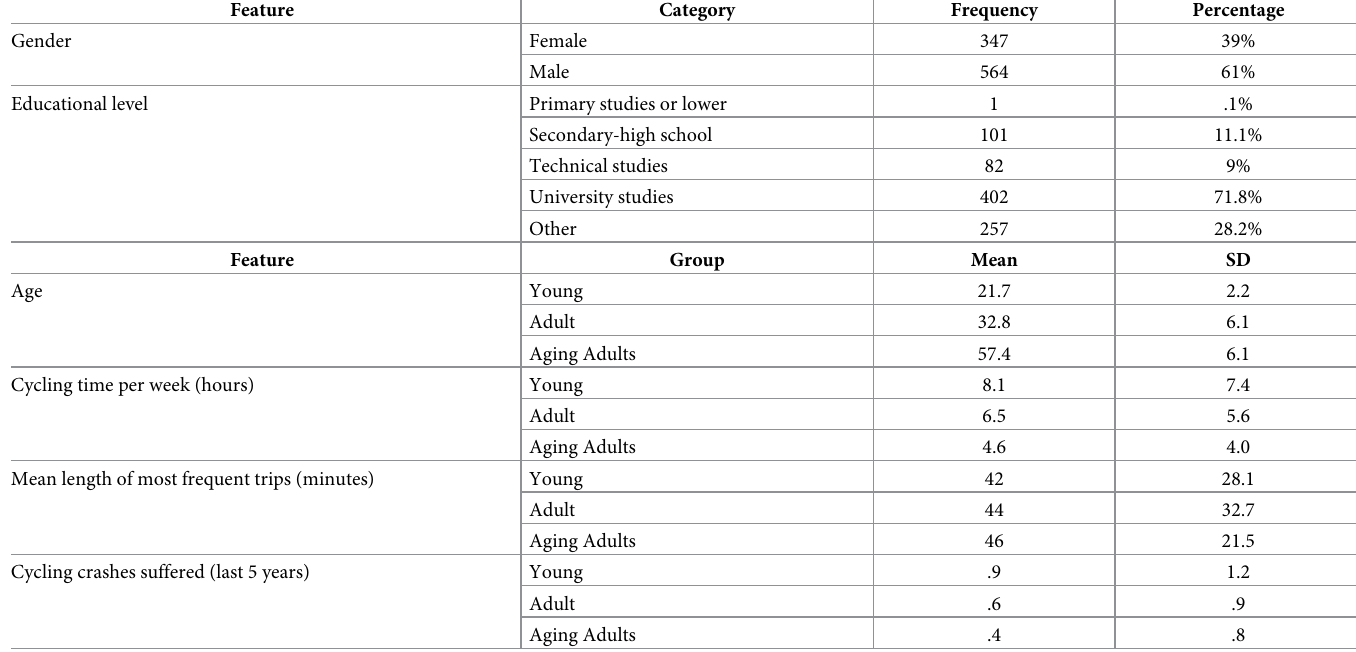
Table 1. Demographic data, cycling patterns and cycling crash rates of the